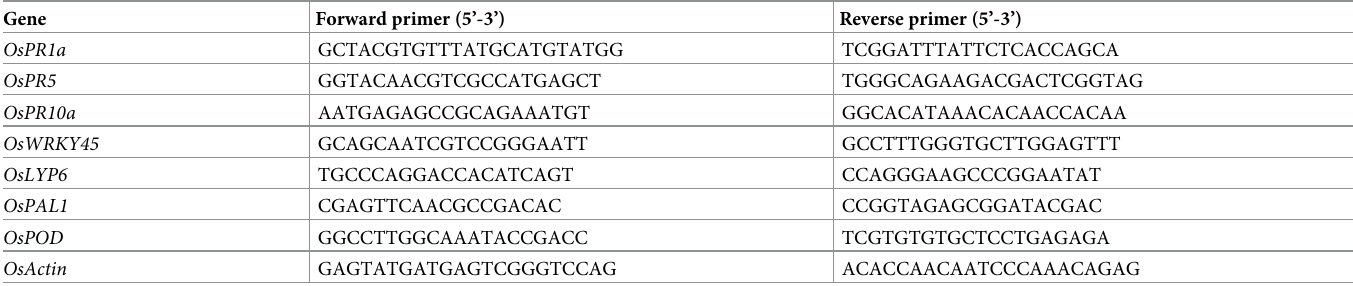
Table 1. The primer sequences of defense-related genes and internal reference